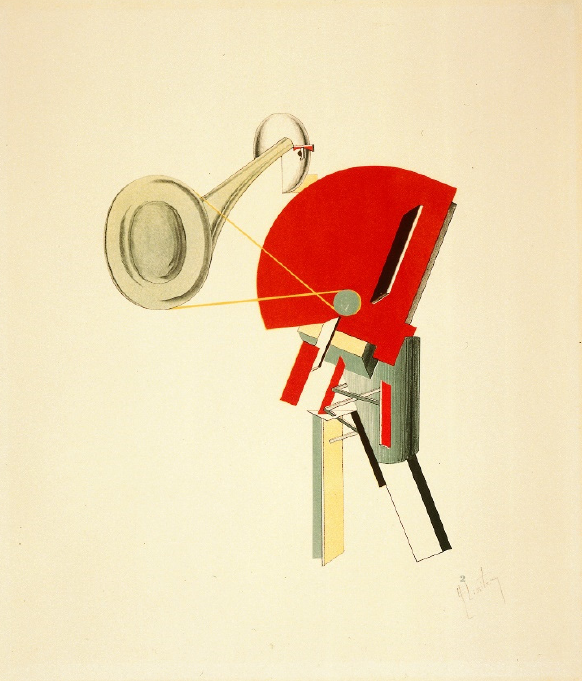
Figure 16. El Lissitzky, ‘The Announcer’, lithograph for the ‘Figurinnenmappe’, 1923. Van Abbemuseum. Photo: Peter Cox.